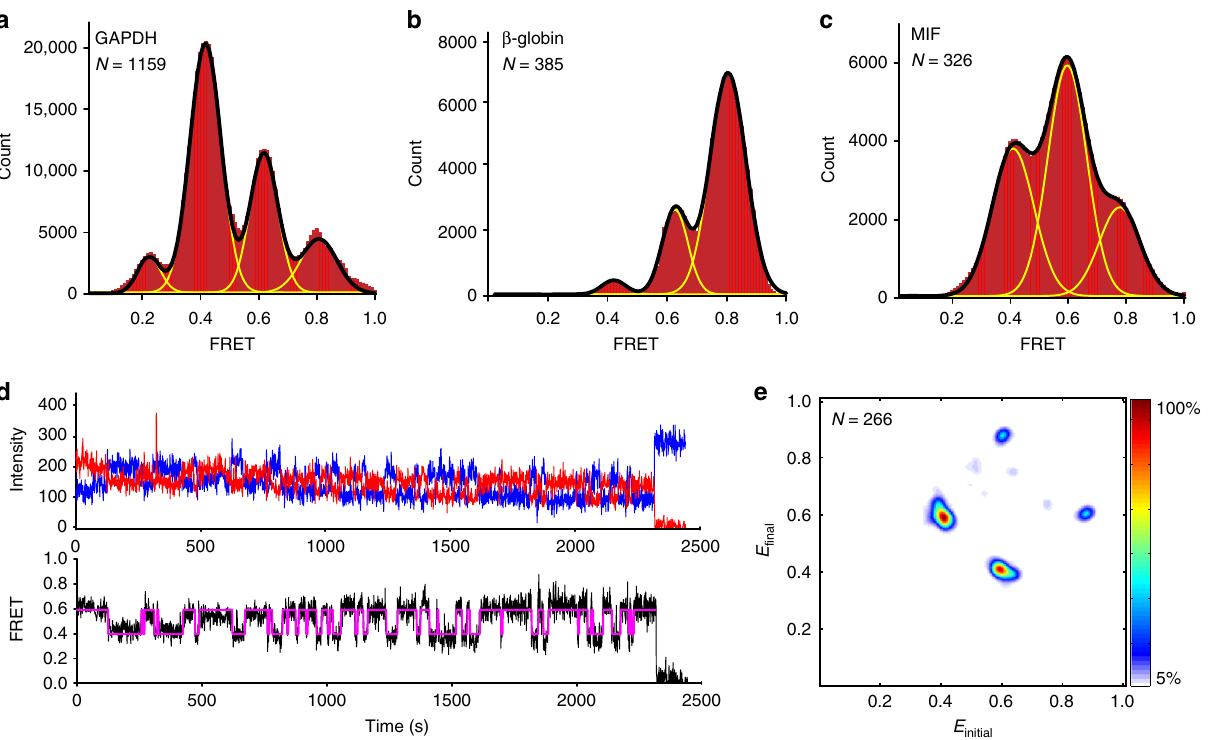
Fig. 2 mRNAs fold into a dynamic ensemble of structures. smFRET was measured between the dyes attached to the 5 ′ end of the 5 ′ UTR and 3 ′ end of the 3 ′ UTR in GAPDH, β -globin, and MIF mRNAs. a – c Histograms, compiled from hundreds of smFRET traces, showing the distribution of the FRET values in a GAPDH mRNA, b β -globin mRNA, and c MIF mRNA folded in the presence of 100 mM KCl and 1 mM MgCl 2 . Yellow lines represent individual Gaussian fi ts and black lines indicate the sum of Gaussians. N is the number of single-molecule traces compiled. d Representative smFRET trace for GAPDH mRNA showing fl uctuations between the 0.4 and 0.6 FRET states. Observed intensities of donor and acceptor fl uorescence and the calculated apparent FRET ef fi ciency are shown in blue, red, and black, respectively. Hidden Markov Model fi t is shown in magenta. e Transition density plot (TDP) analysis of 5114 fl uctuations between different FRET states in 266 HMM-idealized FRET traces obtained for GAPDH mRNA. The frequency of transitions from the starting FRET value ( x axis) to the ending FRET value ( y axis) is represented by a heat map. The range of FRET ef fi ciencies from 0 to 1 was separated into 200 bins. The resulting heat map was normalized to the most populated bin in the plot; the lower- and upper-bound thresholds were set to 5% and 100% of the most populated bin,